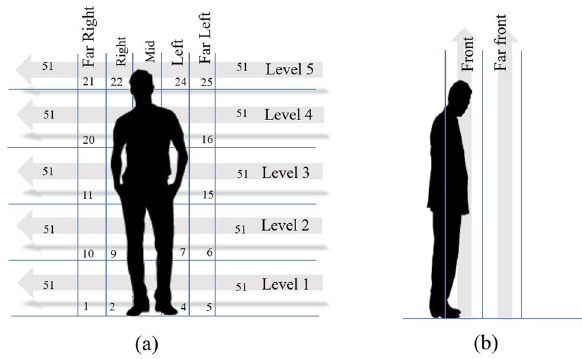
Figure 2: Division of activity space into regions and levels. ( a ) Front view of the activity space and ( b ) side view of the front space.